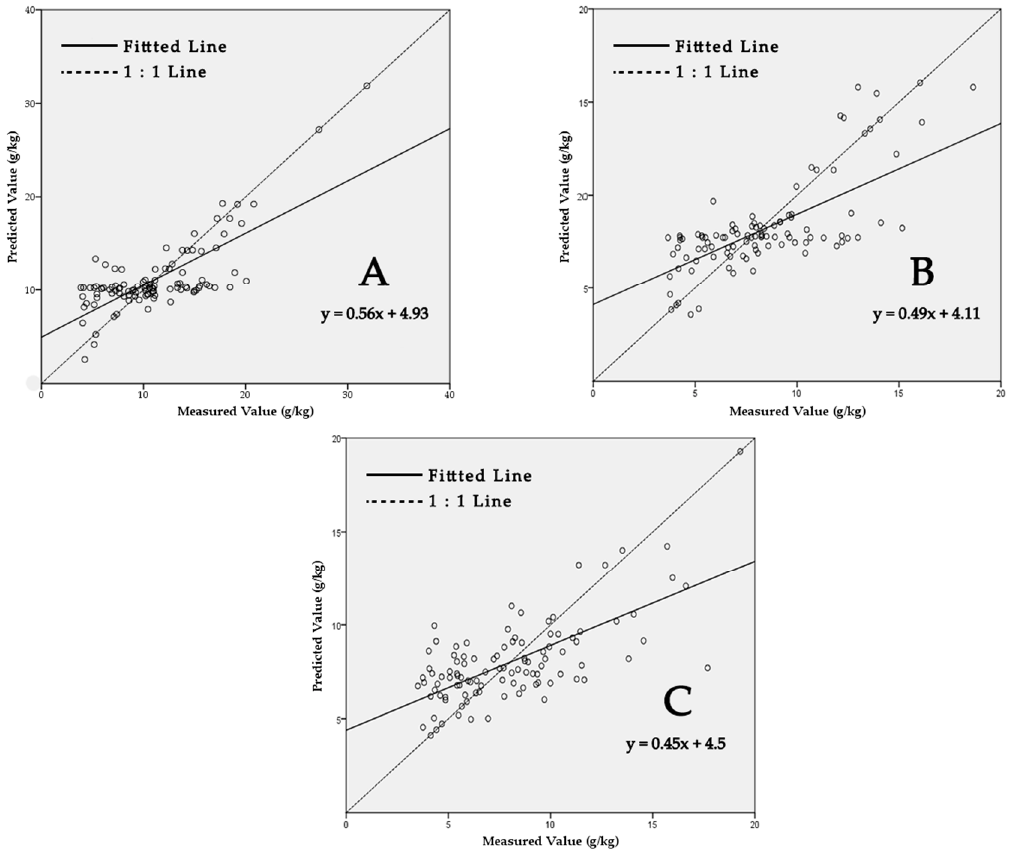
Figure 4. Performance of the hybrid method combining artificial neural network and ordinary kriging (ANN ‐ OK) in predicting wetland soil organic carbon concentration (SOCc) at different depths: ( A ) 0–30, ( B ) 30–60, and ( C ) 60–100 cm.